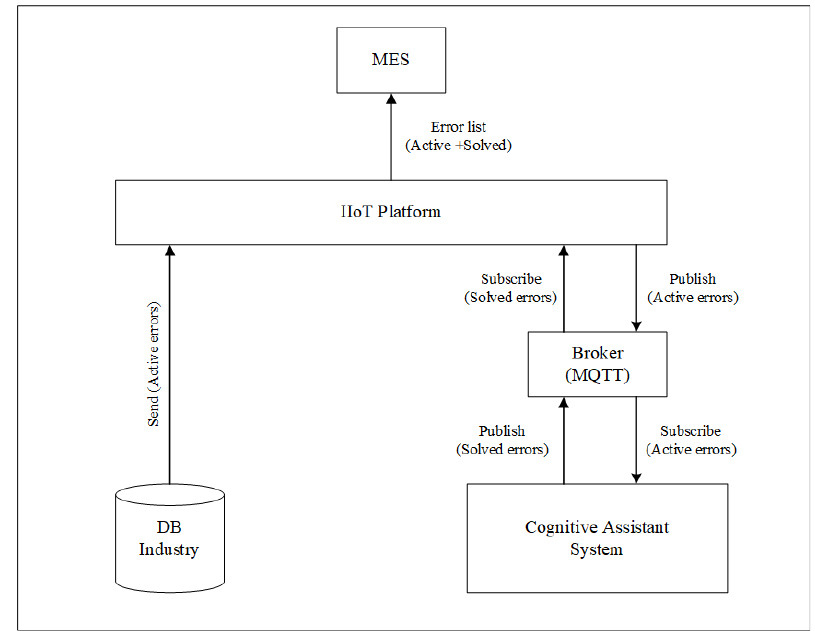
Figure 3. Proposed data transmission architecture for the automotive industry.